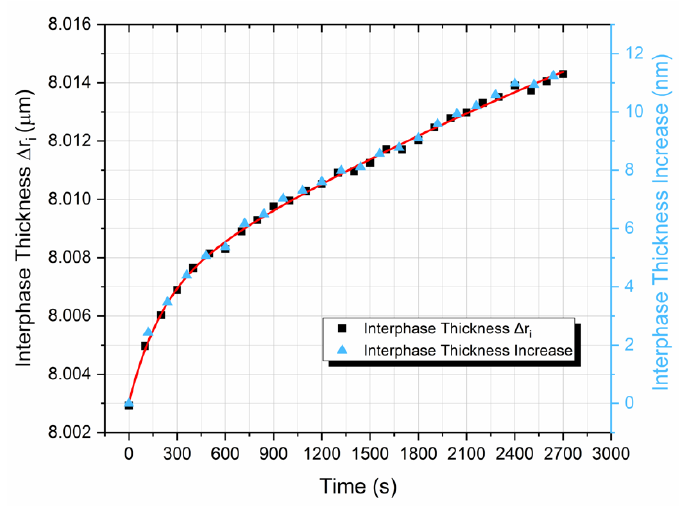
Figure 12. Prediction of the thickness of the hybrid viscoelastic interphase as a function of time.